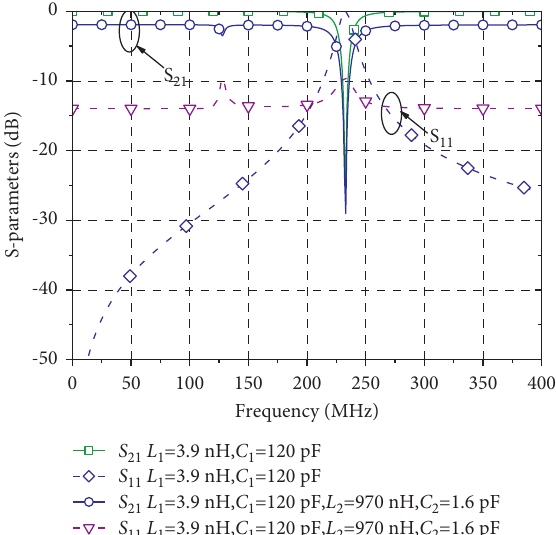
Figure 2: S parameters of the band-stop filter and band-pass negative group delay band-stop